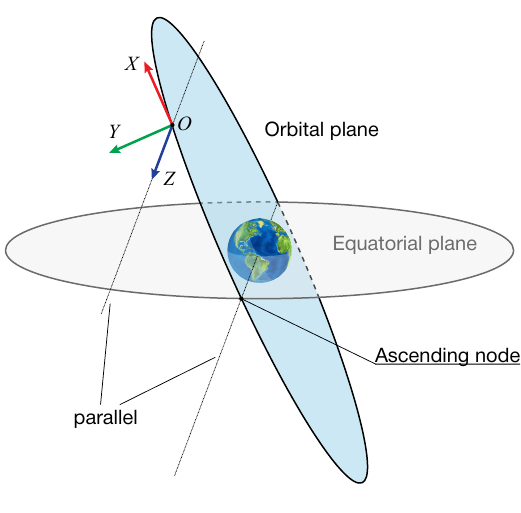
Figure 1. Semi-orbital reference